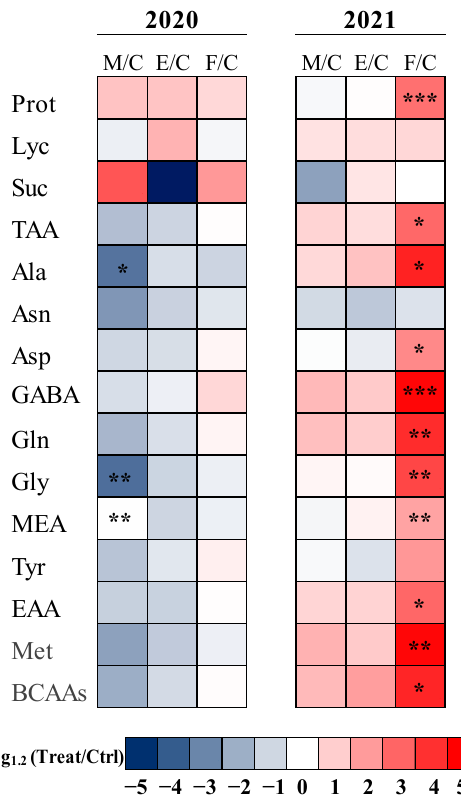
Figure 1. Heat map analysis summarizing statistically significant tomato fruit responses to different commercial biostimulant treatments (M = Micosat F Tab Plus, E = EKOprop NX, F = Fidelius) compared to C = control. Results were calculated as Logarithm base 1.2 (Log1.2) of treatments/control in the two years of agronomic cultivation (2020–2021) and visualized using a false color scale with red indicating an increase and blue a decrease. No differences were visualized by blank squares. *, **, *** = significant at p ≤ 0.05, 0.01 and 0.001, respectively, and indicate significant differences between treatment × year according to Tuckey’s range test ( p ≤ 0.05).